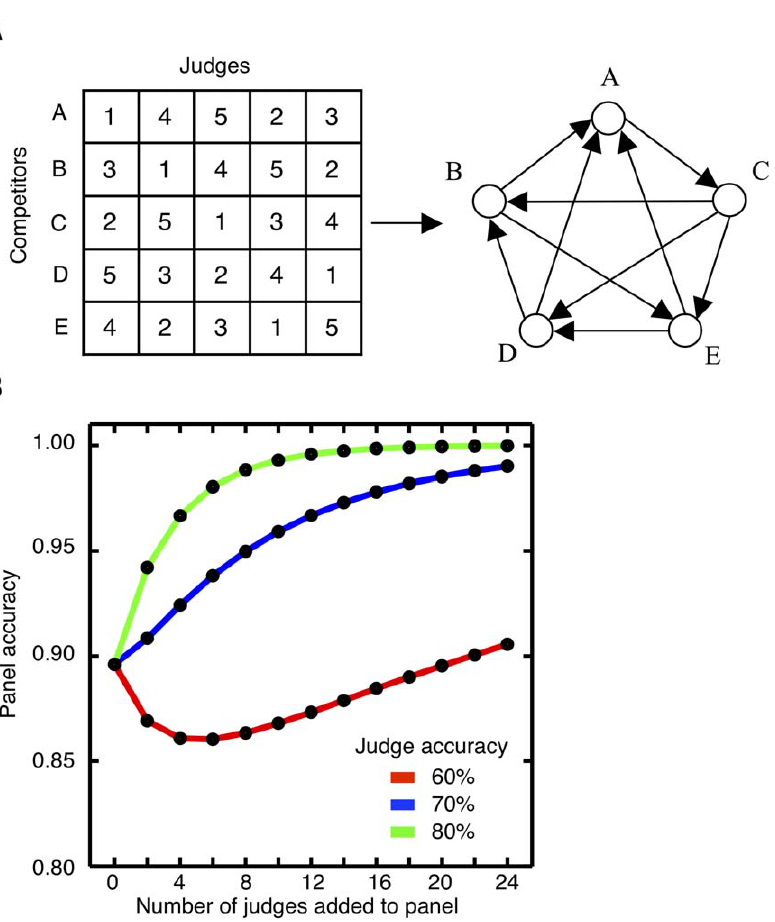
Figure 1. Condorcet results. (A) Voter’s paradox. A hypothetical ranking of 5 competitors evaluated by 5 judges, where 1 is most preferred and 5 is least. By comparing options two at a time with majority rule, we produce a directed graph. The nodes are the competitors and the edges stemming from a node indicate which competitors that node beat. For example, the edge from B to A represents more judges favored B to A. The cycle through all of the nodes is indicative of the Voter’s paradox (3): no clear winner. (B) The Condorcet Jury Theorem. Given a panel of 3 judges of 80% accuracy, we show the effects of adding judges with accuracy of 60% (red), 70% (blue), 80% (green) on the group’s accuracy (panel accuracy) under majority rule. According to the Condorcet Jury Theorem if all judges have the same accuracy (green), then adding more judges increases the panel’s accuracy. However, if the judges have a lower accuracy, the judge accuracy curve is not necessarily monotonic. The 60% accurate judges initially detract from the panel’s accuracy and do not improve it until 22 judges are added (25 total in the panel).